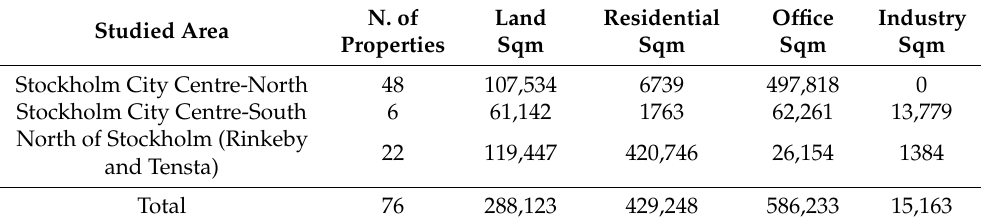
Table 8. Descriptive statistics for areas owned by non-Swedish in the studied areas. N. of Land Residential Office Industry Studied Area Properties Sqm Sqm Sqm Sqm Stockholm City Centre-North 48 107,534 6739 497,818 0 Stockholm City Centre-South 6 61,142 1763 62,261 13,779 North of Stockholm (Rinkeby and Tensta)